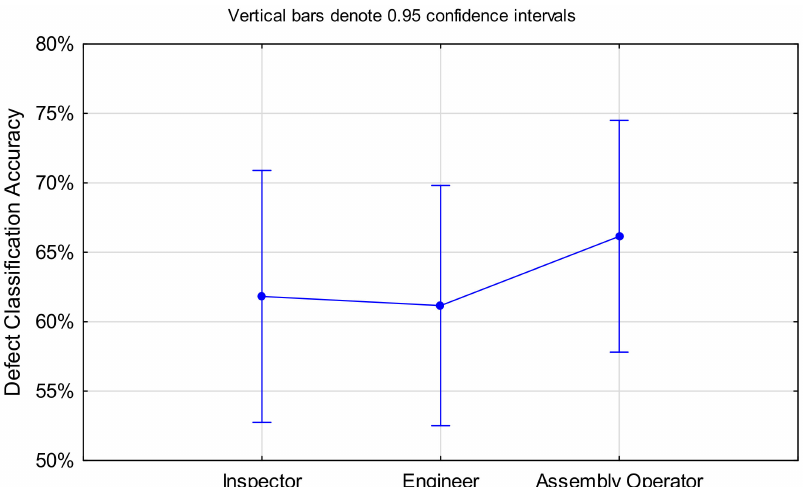
Figure 12. Mean plot of defect classification accuracy by